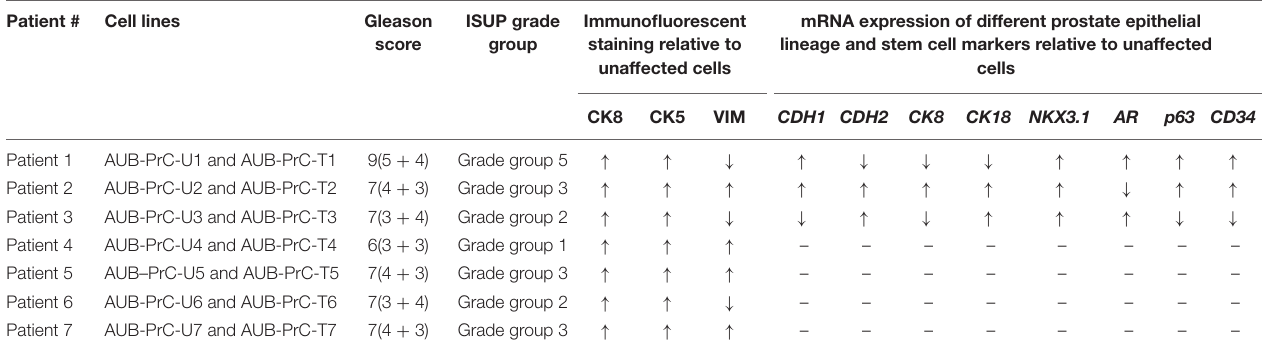
TABLE 2 | Table summarizing major characteristics of patients and AUB-PrC cell lines generated. Patient # Cell